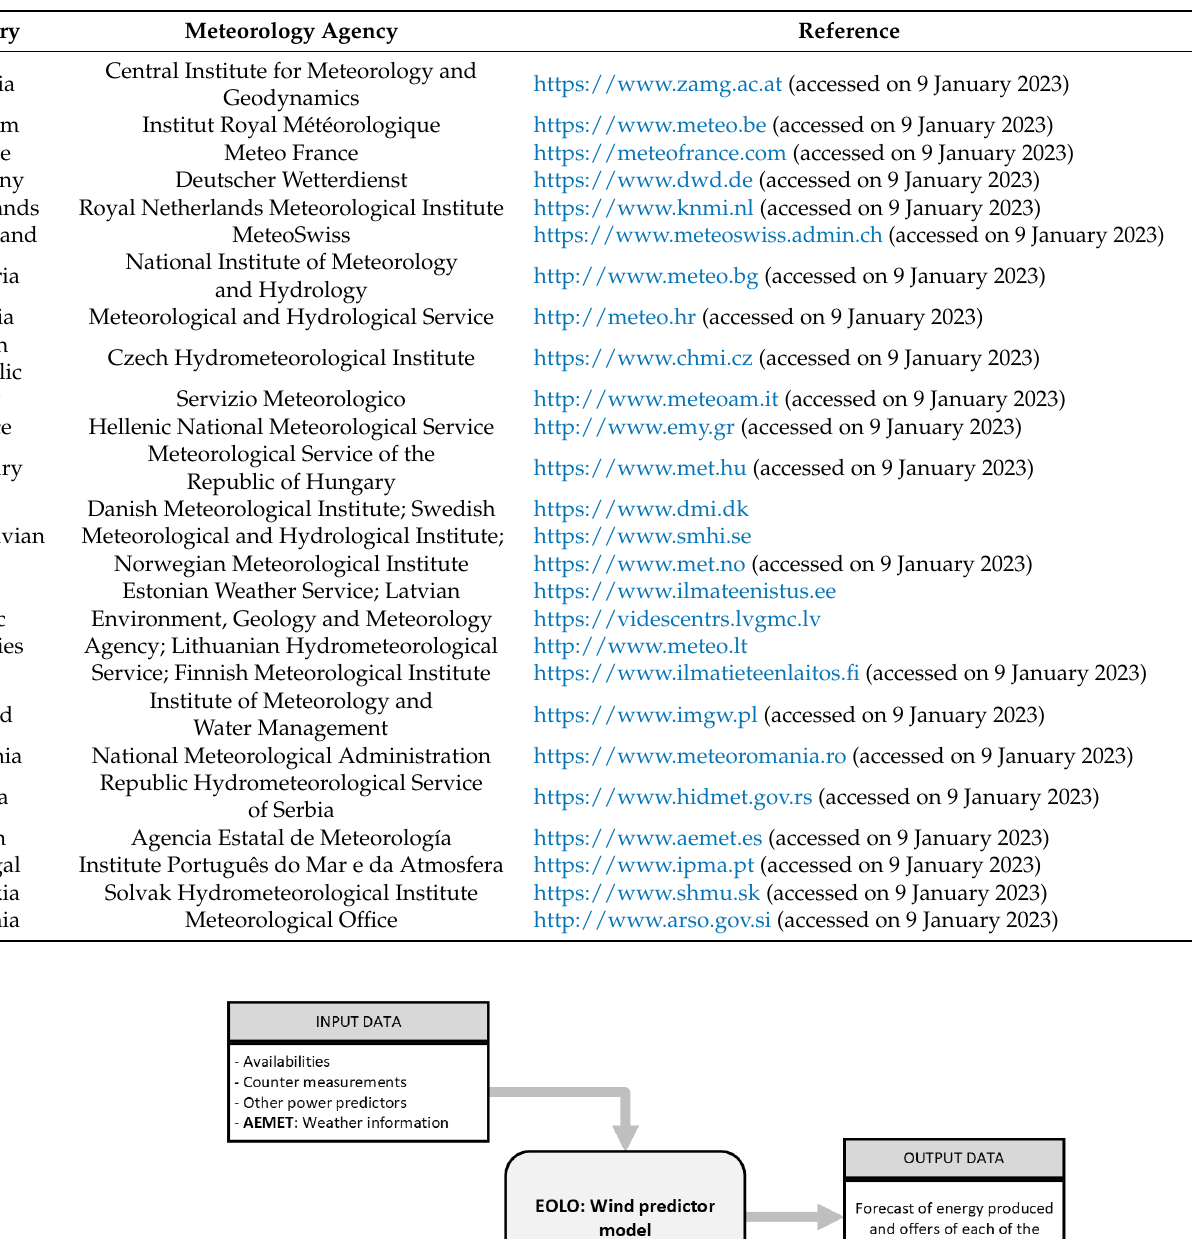
Table 3. European information about meteorology agencies.